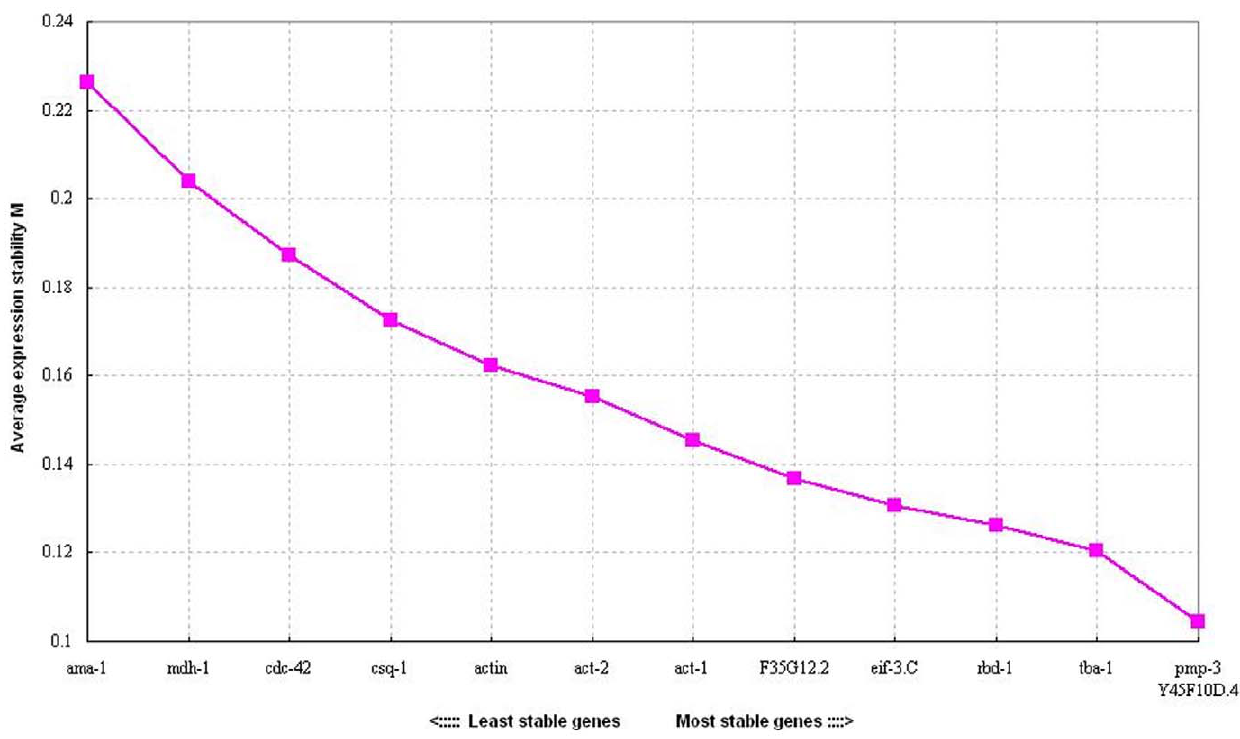
Figure 2. The average expression stability values of the thirteen candidate reference genes analyzed by geNorm. The lower the M value, the higher the stability.